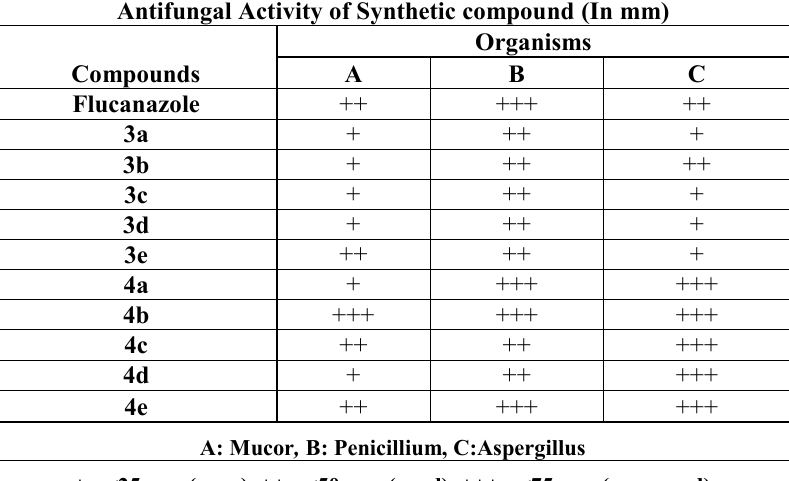
Table 3: Antifungal activity of Chalcones and Pyrazoline derivatives. Antifungal Activity of Synthetic compound (In mm) Compounds